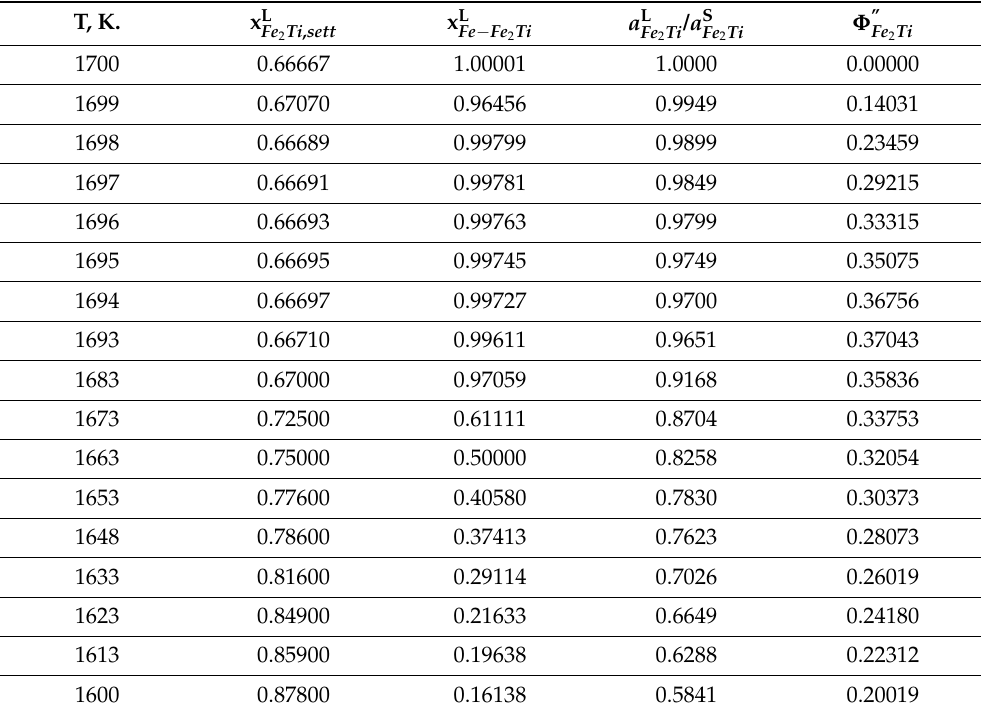
Table 1. The initial data of the Fe 2 Ti crystallization region of the Fe 2 Ti-Fe quasi-system. T, K. x L Fe 2 Ti ,